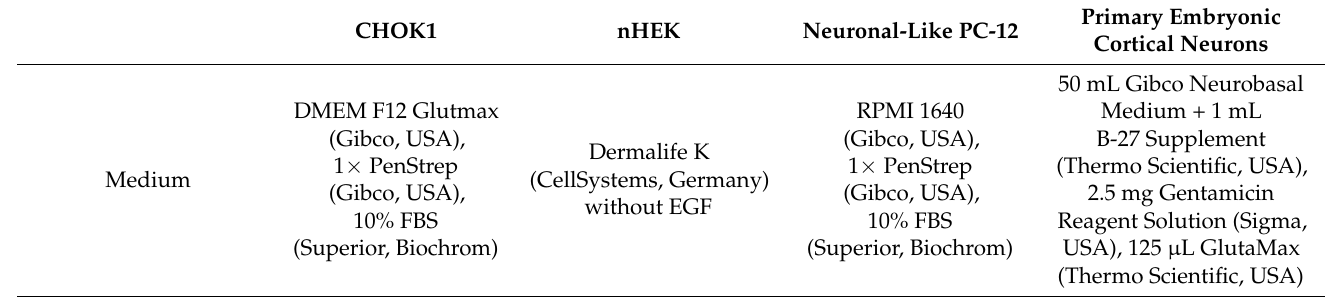
Table 1. Cell culture medium for assessed cell lines and applied transfection protocols. Overview of all media and supplements and transfection protocols applied for each assessed cell line are provided. Amounts are given in ( v / v ).